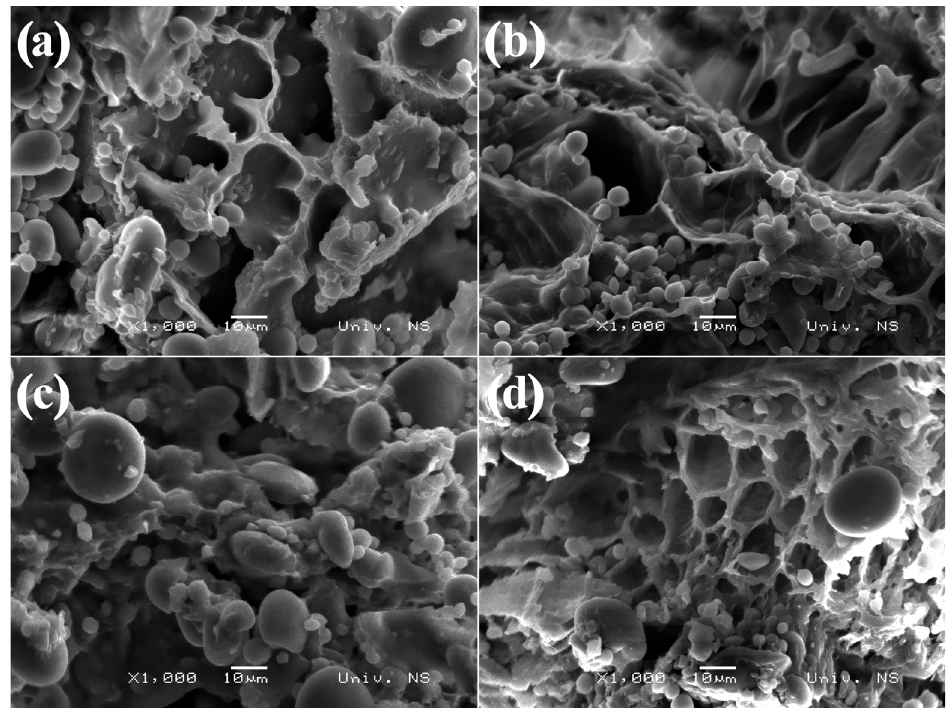
Figure 2. Scanning electron micrographs of ( a ) modern wheat, ( b ) emmer, ( c ) khorasan and ( d ) spelt sourdough samples at 1000× magnification.